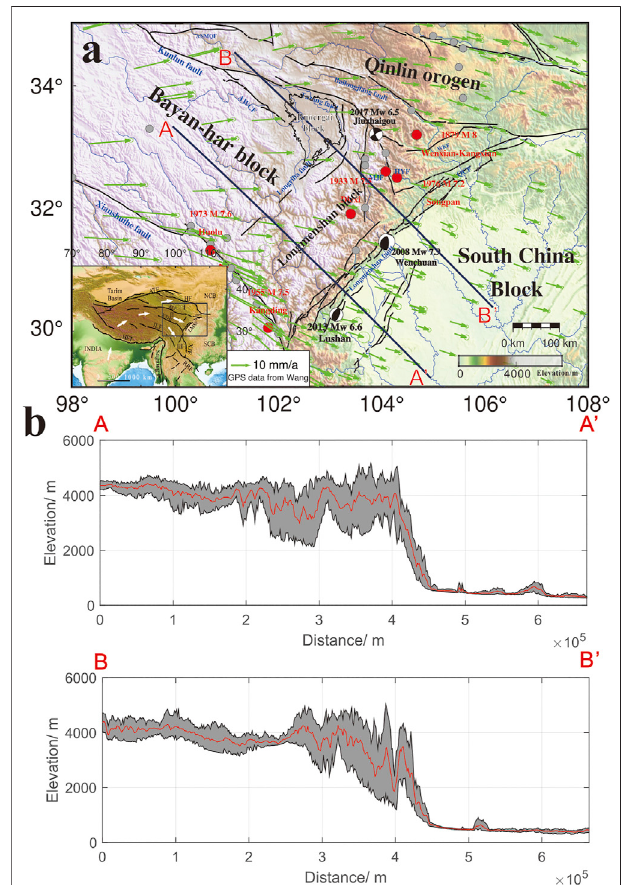
FIGURE 1 | (A) . Faults and seismicity in the eastern Tibetan Plateau and neighboring regions (the location is indicated by a box in the inset). The focal mechanism solutions indicate the 2008 Mw 7.9 Wenchuan earthquake, 2013 Mw 6.6 Lushan earthquake, and 2017 Mw 6.5 Jiuzhaigou earthquake retrieved from the Global Centroid Moment Tensor (CMT) database (formerly referred to as the Harvard CMT catalog) (http://www.globalcmt.org/ CMTsearch.html).ThedarkgraycircleindicateshistoricaleventsaboveMw7. TheredcircleindicateseventsaboveMw7.5nearselectedfaultsfrom1840to 2000 (obtained from the Chinese Earthquake Administration). The green arrow is GNSS data (Wang and Shen, 2020). The dashed box indicates fi gure area. The area enclosed by the black line delineates the Ruoergai rigid block (Hu et al., 2018). ANMQF: Animaqing fault; AWCF: Awancang fault; HF: Haiyuan fault; HYF: Huya fault; MJF: Minjiang fault; QCF: Qingchuan fault; QLF: Qinling fault, WKF: Wenxian – Kangxian fault. The inset map demonstrated major tectonic features of the Tibetan Plateau. ATF: Altyn Tagh fault, HFT: Himalayan Frontal Thrust, JLF: Jiali fault, NCB: North China Block, RRF: Red River fault, SCB: South China Block, XJF: Xiaojiang fault, XSHF: Xianshuihe fault, I – Qaidam-Qilian Block, II – Bayan Har Block, III - Sichuan – Yunnan block. The white arrow shows the block movement direction. (B) . Pro fi les A-A ’ cross the southern Longmen Shan fault, and Pro fi lesB-B ′ crossthenorthernLongmenShanfault.Theredlineindicatesthe average elevation. The gray range indicates the highest and lowest elevation